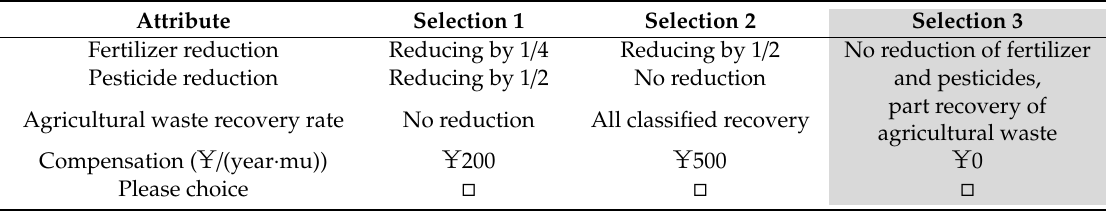
Table 1. A sample of the choice set.